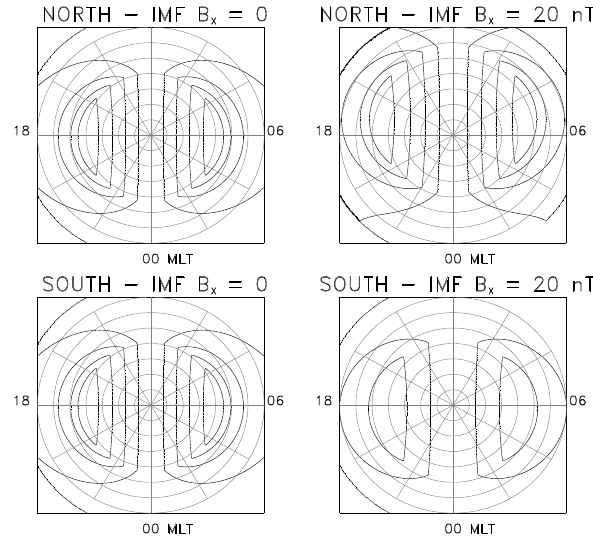
Fig. 2. Potential distribution in (top) Northern and (bottom) South- ern Hemispheres for (left) IMF B X = 0 and (right) IMF B X = 20nT. Circles indicate latitudes by steps of 10 ◦ . Equipotentials are shown by steps of